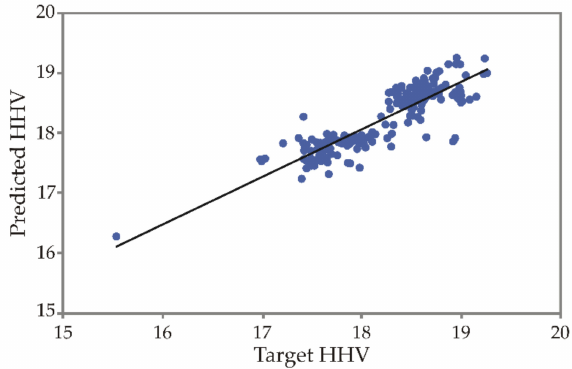
Figure 4. Predicted HHV vs. target